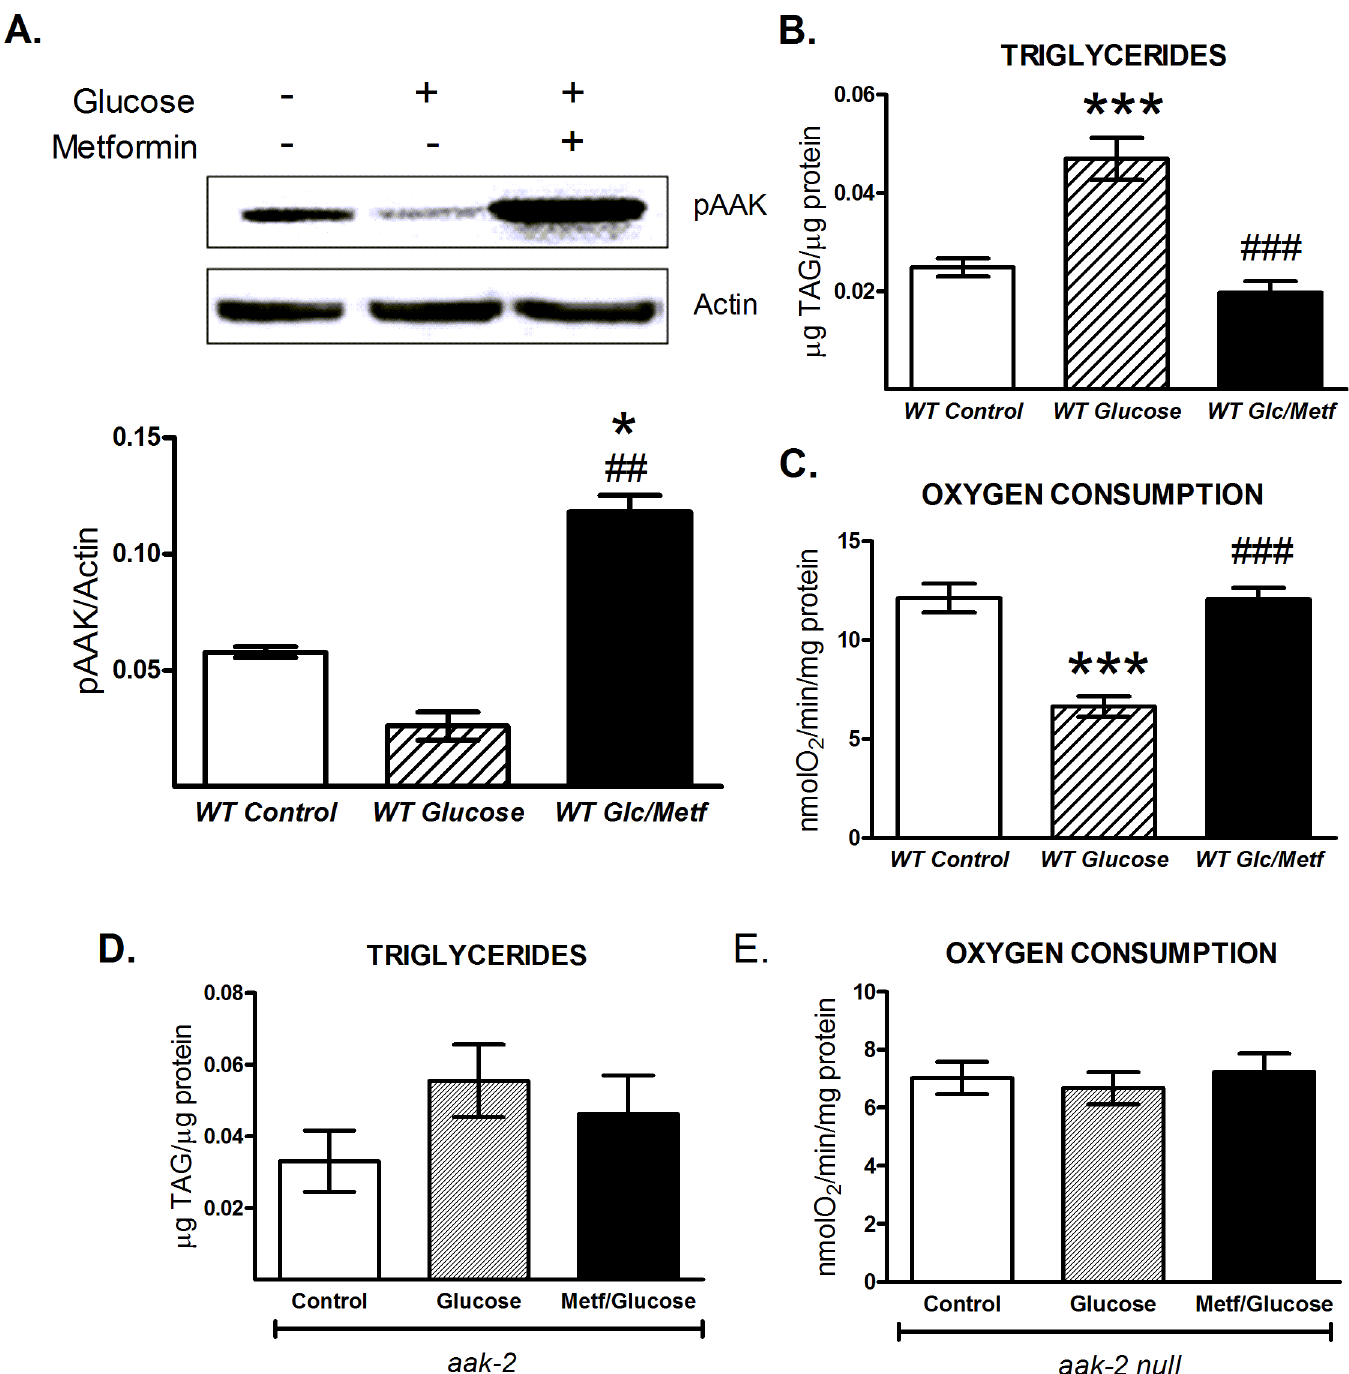
Fig 7. Metformin reverses the deleterious effects of dietary glucose in C . elegans in an AAK-dependent manner. A-C) Adult wild-type (WT) or D-E) aak-2/ok524 nematodes were grown on 100 mM glucose with or without 50 mM metformin for 24 h. A) the top panel is a representative Western blot of AAK phosphorylated (pAAK) at Thr243, where the intensity of bands represents the phosphorylation level, corresponding to kinase activation. B and D) triglyceride content and C and E) oxygen consumption rates. The graphs represent the mean ± SEM of three independent experiments, * p < 0.05, *** p < 0.001 vs. WT control and ## p < 0.01, ### p < 0.001 vs. WT glucose, one-way ANOVA with Bonferroni's post hoc test using GraphPad Prism.